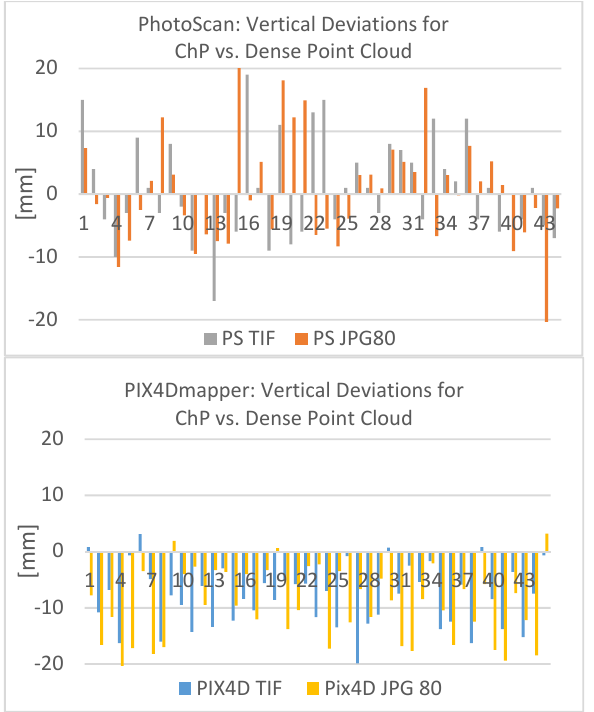
Figure 3. Vertical deviations between checks points and dense point cloud. Positive value - point cloud is below the ChP; negative value - above the ChP. PhotoScan point cloud (top) and PIX4Dmapper point cloud (bottom)